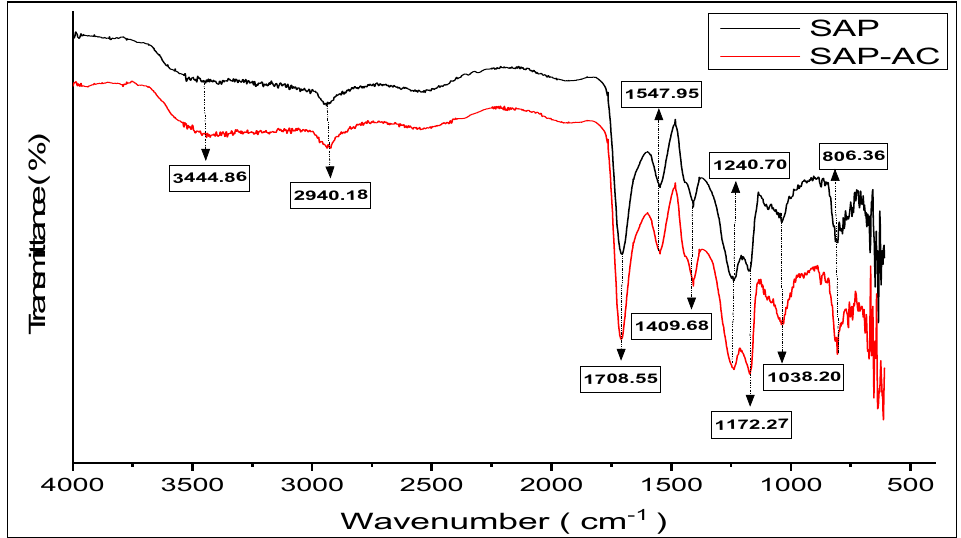
Figure 16. FTIR spectra of the synthesized SAP and SAP-AC hydrogels.